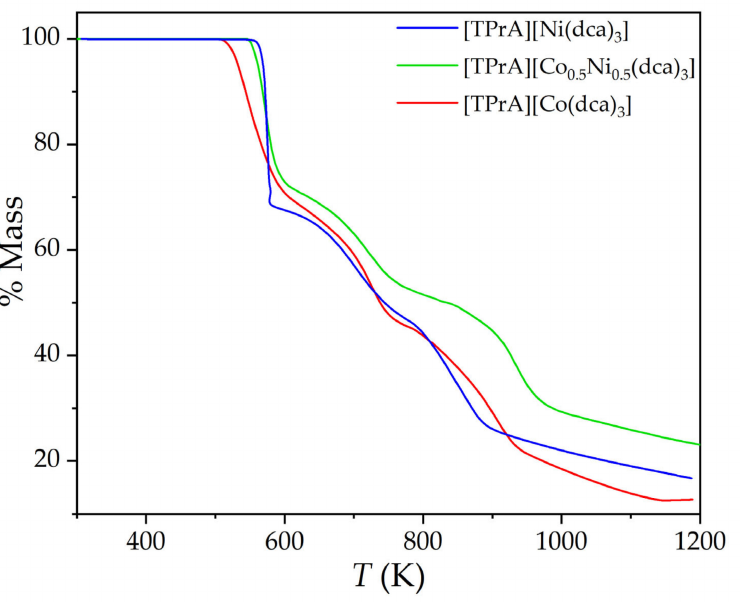
Figure 6. TGA curves of [TPrA][Co x Ni 1 − x (dca) 3 ], where x = 1.0, 0.5 and 0.0, from 300 K to 1200